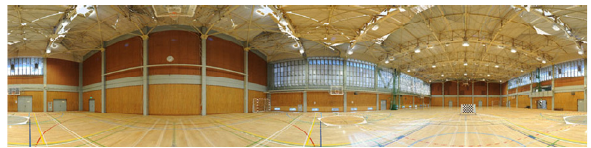
Figure 9. Rendered panoramic image using a point